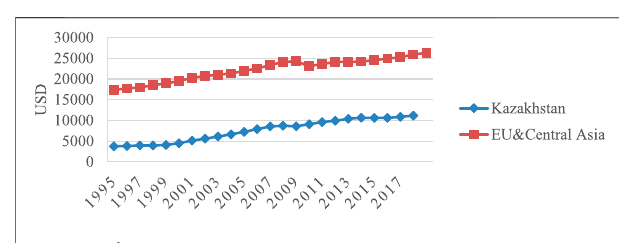
FIGURE 3 | Per capita